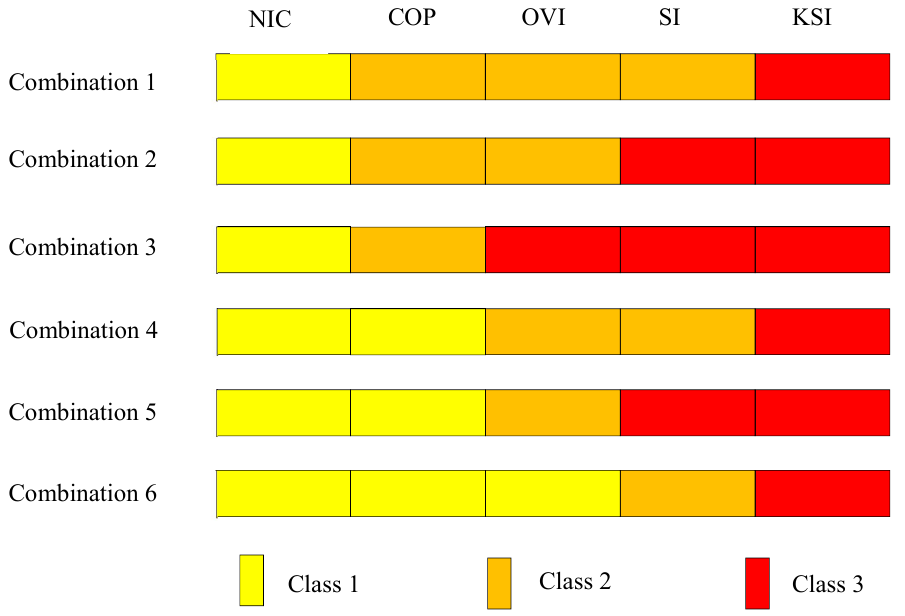
Figure 4. The proportion of classes in each method of categorizing.